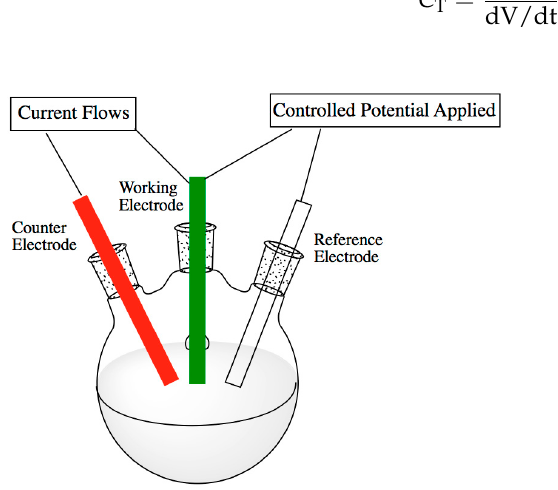
Figure 1. A typical schematic presentation of a three-electrode arrangement. Reproduced from [11] under license CC BY-NC-SA 3.0.